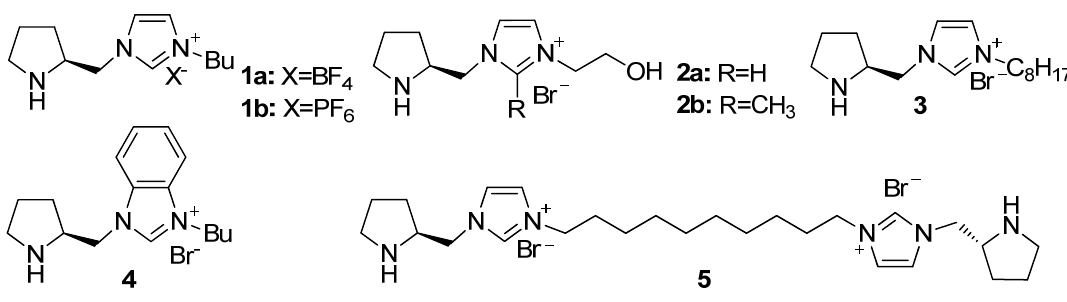
Figure 2. Ionic liquid (IL) immobilized pyrroline-type